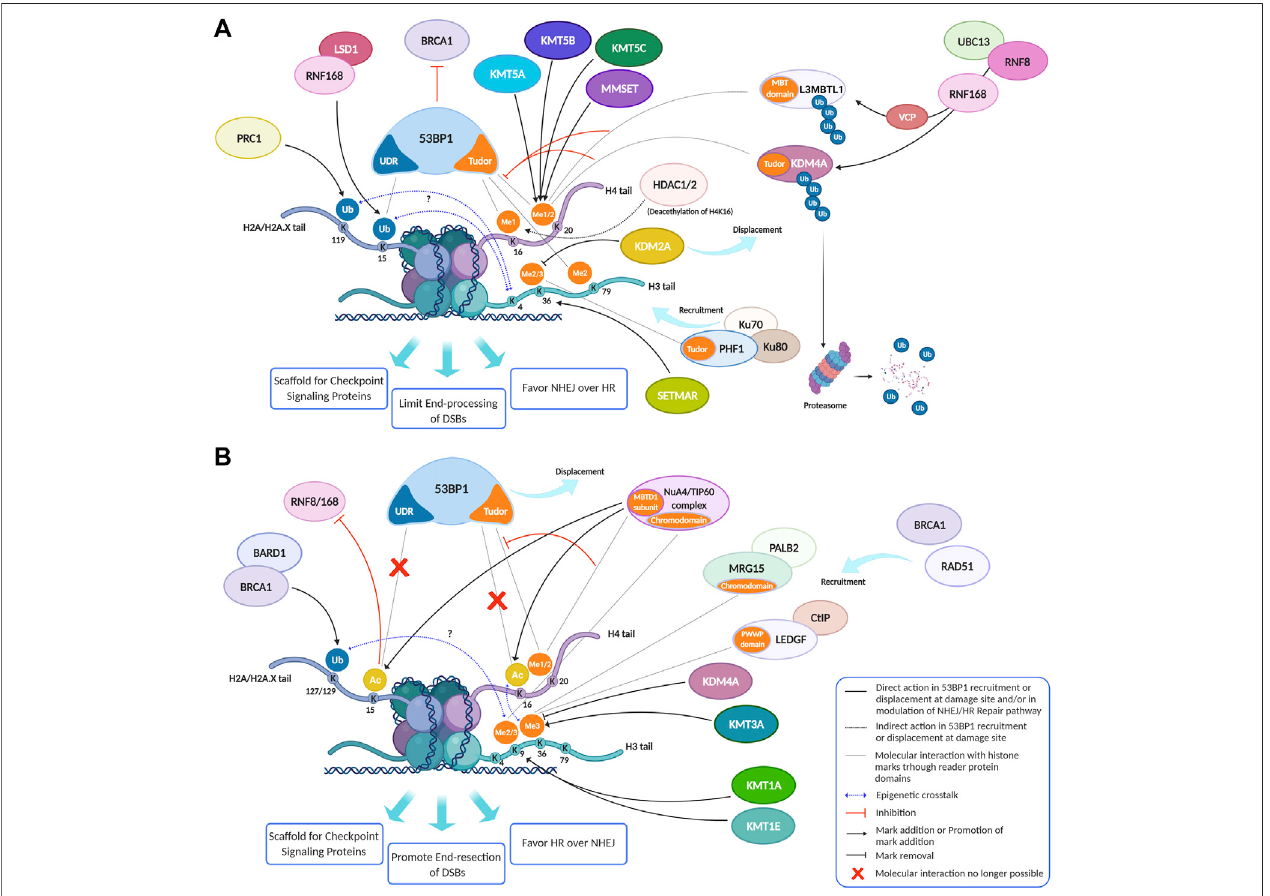
FIGURE 3 | Histone modi fi cations, dynamically added or removed around the DNA damage site, constitute an integrated signal for the DSBs repair pathway choice. (A) 53BP1 is a master regulator of DNA double-strand break repair pathway choice toward NHEJ and its binding to chromatin is mainly regulated by speci fi c histone modi fi cations, comprising H2A ubiquitylation and H3 and H4 methylation. Indeed, speci fi c HPTMs can generate a docking site for 53BP1, which binds the ubiquitinated H2A/H2A.X K13/15/119 through its UDR motif and H4K20me2, H4K16me1, and H3K79me2 through its tandem Tudor domain. Therefore, despite H4K20me2 being the main histone mark involved in 53BP1 recruitment, other marks may contribute to it. For example, the deacetylation of H4K16 by HDAC1/2 indirectly promotes the 53BP1 recruitment and the NHEJ over HR, because it makes possible the methylation of this lysine residue. Under normal conditions, the H4K20me2 mark is masked by various interacting proteins, including L3MBTL1 and KDM4A/JMJD2A. Upon DNA DSBs induction, the ATM phosphorylation cascade promotes therecruitment ofthe E3ubiquitinligaseRNF8totheDNAdamage site,which,together withtheE2ubiquitinligaseUBC13,promotes therelocation oftheE3 ubiquitin ligase RNF168 to the DNA break sites. LSD1 may favor the 53BP1 recruitment interacting with RNF168 and/or thanks to a possible epigenetic cross-talk between H3K4 demethylation and H2A ubiquitylation. RNF168 catalyzes in turn the H2A K13/15 mono-ubiquitination and the poly-ubiquitination of L3MBTL1 and KDM4A, leading to RNF8-dependent degradation of KDM4A and to VCP-mediated and ubiquitin-dependent removal of L3MBTL1 from chromatin, favoring the unmasking of H4K20me2 and the loading of 53BP1 around the damaged site. LSD1 can also disadvantage 53BP1 recruitment, negatively regulating the interaction between p53 and 53BP1 (not shown). After DSB induction by IR, the H3K36me2 markedly increases, improving the association of early NHEJ factors such as Ku70/ Ku80 and NBS1 at the damage site. Once activated, ATM (not shown) may negatively regulate KDM2A chromatin-binding capacity, favoring its displacement, which favors an increase of H3K36 di-methylation mark near the DNA damage sites by SETMAR. H3K36me3 can favor the retention of the NHEJ-associated factor PHF1, which is recruited in a Ku70/Ku80 dependent way and which supports an open chromatin for the ef fi cient DNA repair. In contrast to H3K36me2, H3K36me3 regulates both NHEJ and HR, probably depending on the relative abundance of its reader factors and/or by the chromatin context. In this regard, pre-existing transcription- associatedandcellcycle-regulatedhistonemodi fi cationstogetherwiththosedamage-inducedregulatetheDNArepairpathways. (B) Thepre-existingH3K36me3mark at actively transcribed gene bodies favors DNA repair by HR pathway choice: in human cells, both LEDGF (Lens epithelium-derived growth factor), via its PWWP reader domain, and MRG15, via its chromodomain, can bind H3K36me3, promoting the recruitment of CtIP and PALB2, two crucial factors for the DNA end-resection and strand invasion,respectively.Moreover,mutuallyexclusivehistonemodi fi cationscancontributetotipthebalancebetweenHRandNHEJinDSBrepair pathwaychoice: aswitchbetweenubiquitylationandacetylationonH2AK15andH4K16canfavorHRoverNHEJ.ThehumanNuA4/TIP60acetyltransferasecomplexisabletoinhibitthe 53BP1 recruitment both through this mechanism and by targeting the same H4K20me2 mark, by binding H4K20me with the MBT (malignant brain tumor) domain of MBTD1, its stable subunit. Moreover, the human NuA4/TIP60 acetyltransferase complex promotes the repositioning of 53BP1 through other mechanisms, such as the acetylation of H2A/H2AX K13/15 that blocks the recruitment of RNF8/168 and through the acetylation of H4K16 that impedes the methylation of this lysin residue, limiting the recruitment of 53BP1. KDM4A, besides masking H3K20me2 and limiting the 53BP1 recruitment thus inhibiting the NHEJ pathway, negatively regulates the DDRalsoremovingH3K36me3markthusinhibitingtheHRpathway.Conversely,KMT3AfavorstheHRthroughthemethylationofH3K36.KMT1EfavorstheHRthough the methylation of H3K9. Indeed, the H3K9me2 mark is involved in the recruitment of NuA4/TIP60 acetyltransferase complex, and H3K9me3 is involved in the recruitment of BARD1/BRCA1 Ub ligase activity on H2AK127 favoring the DNA end-resection, the repositioning of 53BP1 and thus the HR. Created using